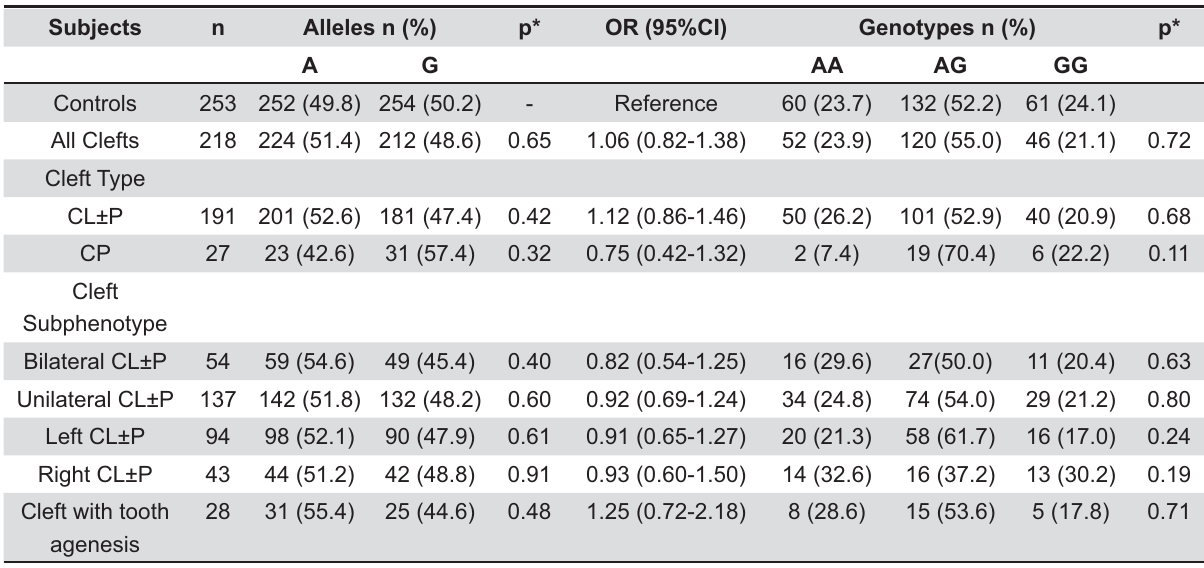
*Fisher’s exact test or chi-square test EGF: epidermal growth factor; CL±P: cleft lip+cleft lip and palate excluding cleft palate only; CP: cleft palate only